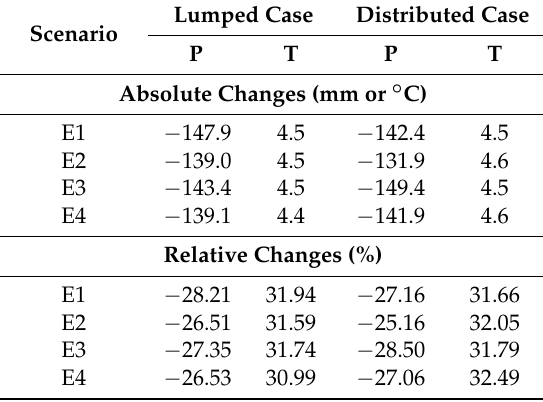
Table 5. Changes of overall mean values for precipitation and temperature scenarios compared to historical data.